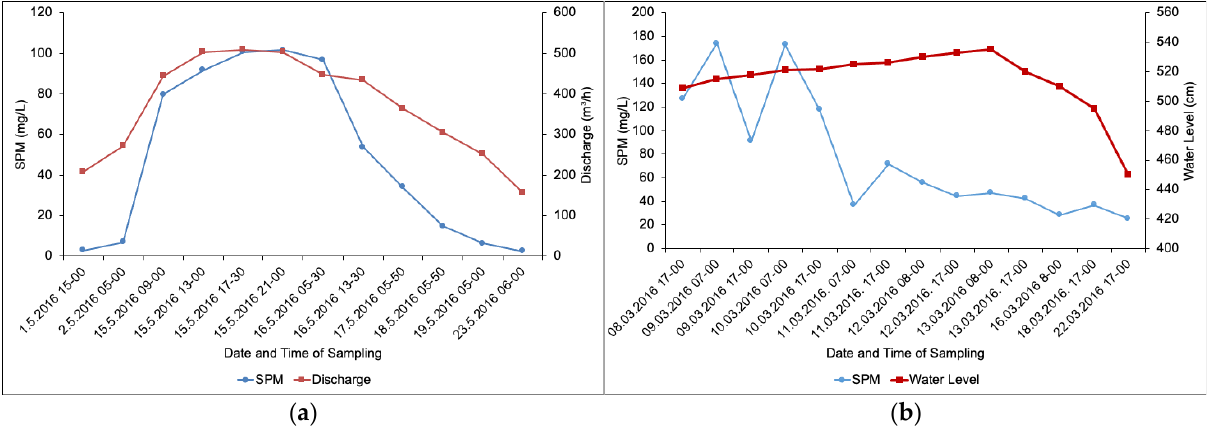
Figure 2. Amount of SPM and discharge/water level at different sampling times during the flash flood events at ( a ) Litija, Slovenia, and ( b ) Belgrade,